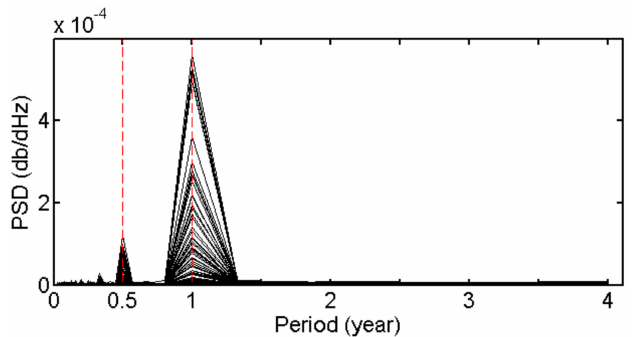
Figure 4. Power Spectral Density (PSD) of 1/ H time series at all grid points over